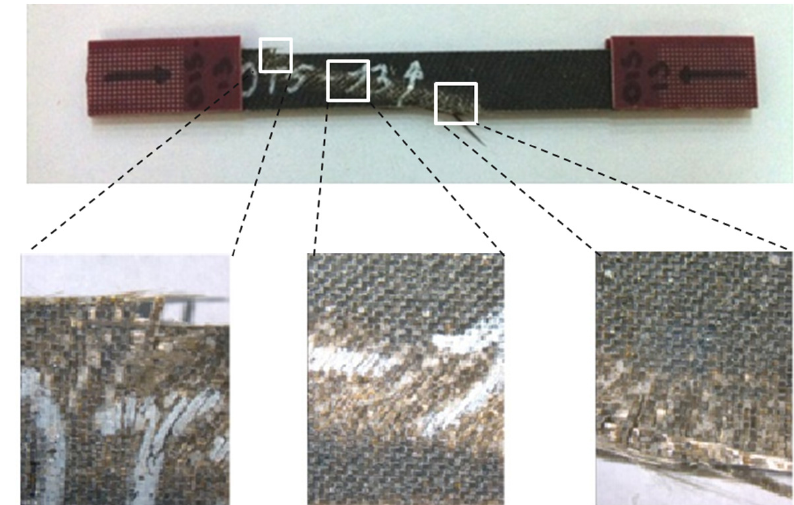
Figure 13: Fractured specimen with twill weave 1/3 fabric reinforcement in the fill direction. The areas enclosed in the square boxes show details of the damage mechanism leading to sample